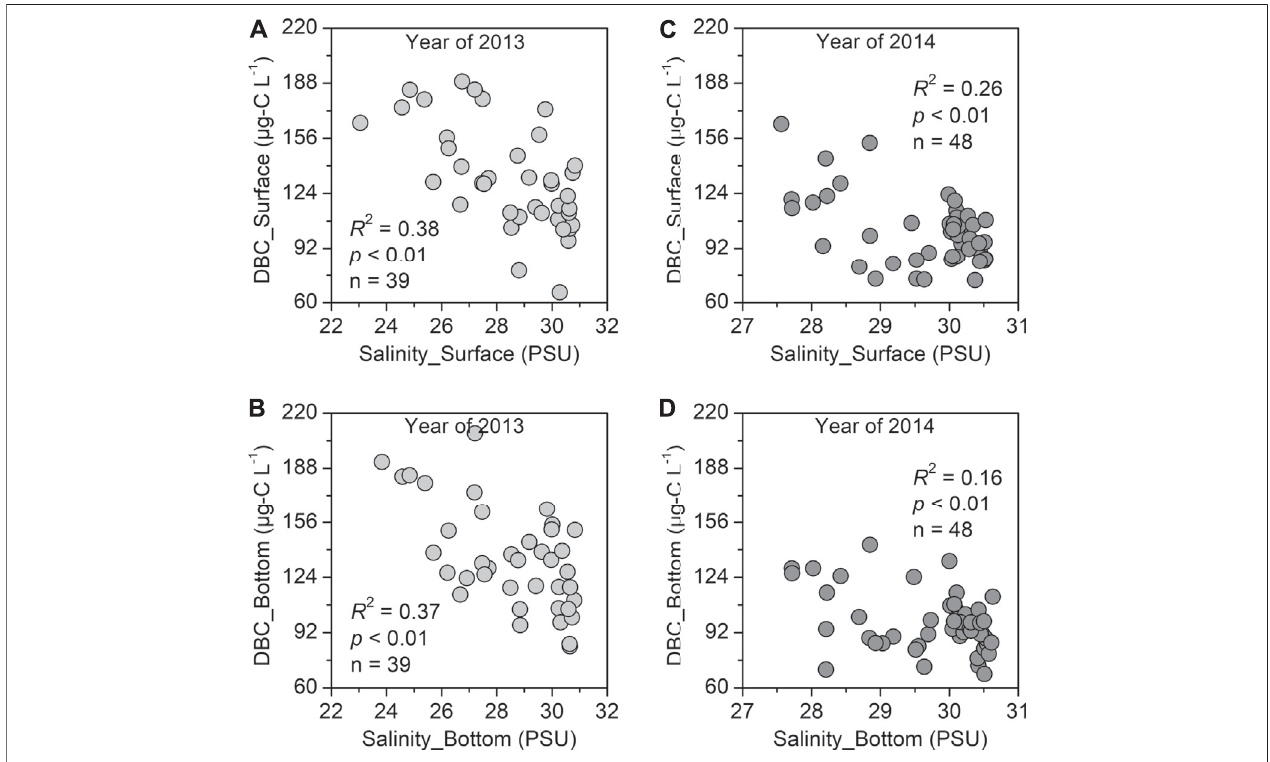
FIGURE 3 | Linear correlations between DBC concentrations and salinity in BHB and LZB in 2013 and 2014. Note: Datasets for illustrating Figures 3A,B and Figures 3C,D are referred to Supplementary Table S4 and Fang et al. (2021), respectively.